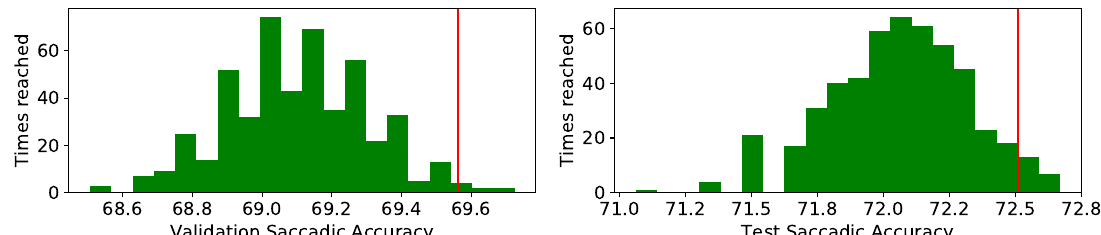
Figure 5. Distribution of the 500 MCD accuracy predictions ( MCDacc i in Algorithm 1) for the validation ( left ) and test ( right ) sets in a single run of the approach. The vertical line represents the classification accuracy of the ensemble MCD ( MCDE in Algorithm 2) model.